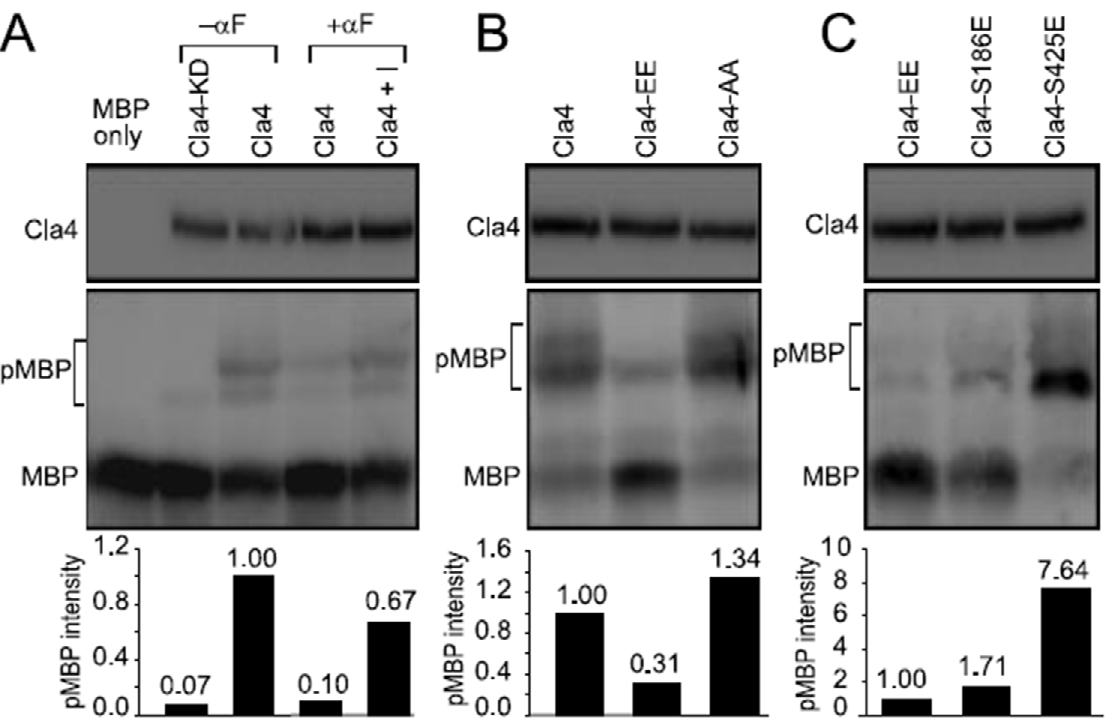
Figure 4. In vitro phosphorylation of MBP by Cla4p. In vitro kinase assays were performed as described in the Materials and Methods. The intensity of the slower-migrating MBP was normalized by the level of immunoprecipitated Cla4p and expressed relative to wild-type Cla4p ( A , B ) or Cla4p-EE ( C ). pMBP indicates phosphorylated MBP. ( A ) Cla4p or Cla4p-KD in the fus3-as1 mutant was purified from mitotic cultures or cells treated with pheromone (MY15342 and 15343) for 2 h in the absence or presence of the inhibitor, 1-NA-PP1. ( B ) Wild-type, a phosphomimetic mutant Cla4p-EE (S186E, S425E), and the non-phosphorylatable mutant Cla4p-AA (S186A, S425A) were purified from mitotic extracts (MY15342, 15351, and 15647). ( C ) Cla4p single and double phosphomimetic mutants were purified from mitotic extracts (MY 15351, 15345, and 15349).